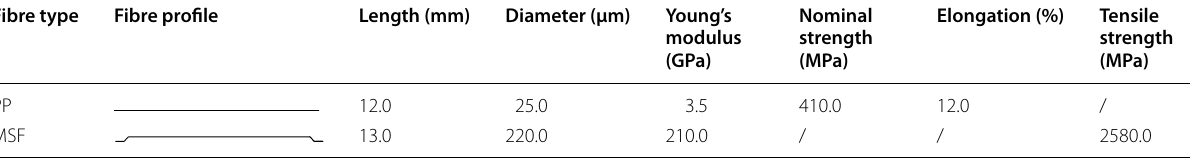
Table 2 Geometry and mechanical properties of MSF and PP